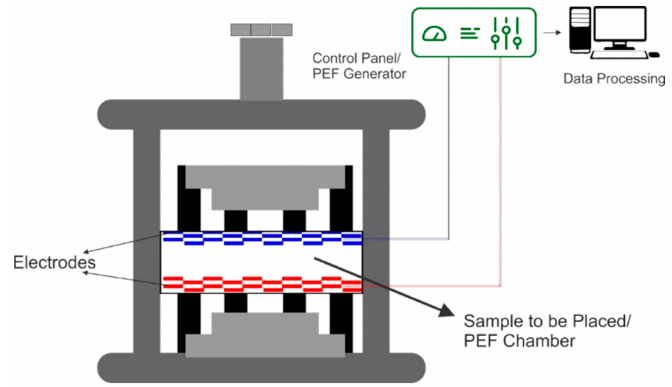
Figure 2. PEF (pulsed electric field) batch extraction system.